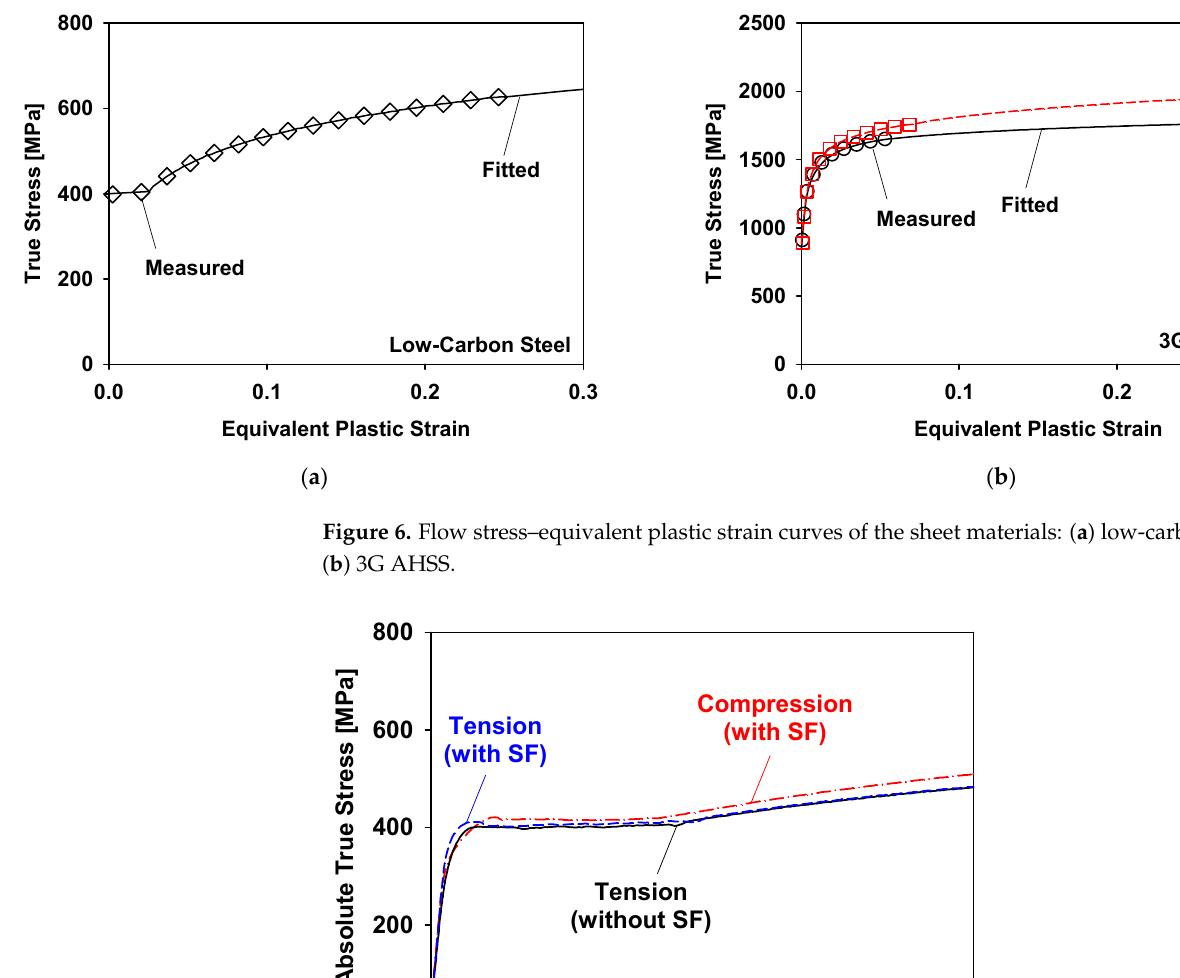
Figure 5. Engineering stress–strain curves of the sheet materials: ( a ) the low ‐ carbon steel and ( b ) the